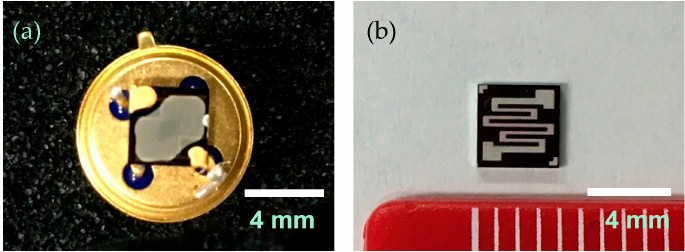
Figure 2. Pt, Pd, and Au/SnO 2 sensor element: ( a ) front (Pt, Pd, and Au/SnO 2 thick film with platinum comb-type electrode); and ( b ) back (platinum heater). The substrate size was 4 × 4 mm 2 .